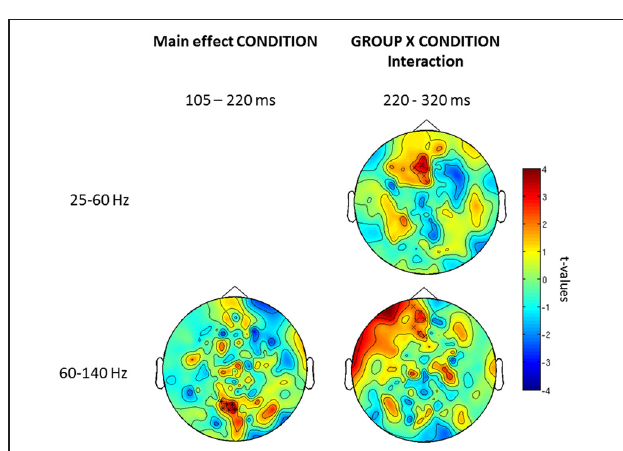
FIGURE 5 | Post-hoc contrasts for the non-Parametric ANOVA indicating the main effects of group (left) and condition (right) for both low (top) and high (bottom) gamma-band oscillations at the sensor level. For the main effect of group (left column), red colors indicate increased activity in controls while blue color suggests increased gamma-band power in schizophrenia patients relative to controls. For the main effect of condition (right column), red colors indicate higher gamma-band activity to faces while increased spectral power to no-face stimuli is represented in blue. The topographies depict corrected t -values and the channels that form a statistically significant cluster are indicated ( ∗ , p < 0 . 001; x, p < 0 . 05).